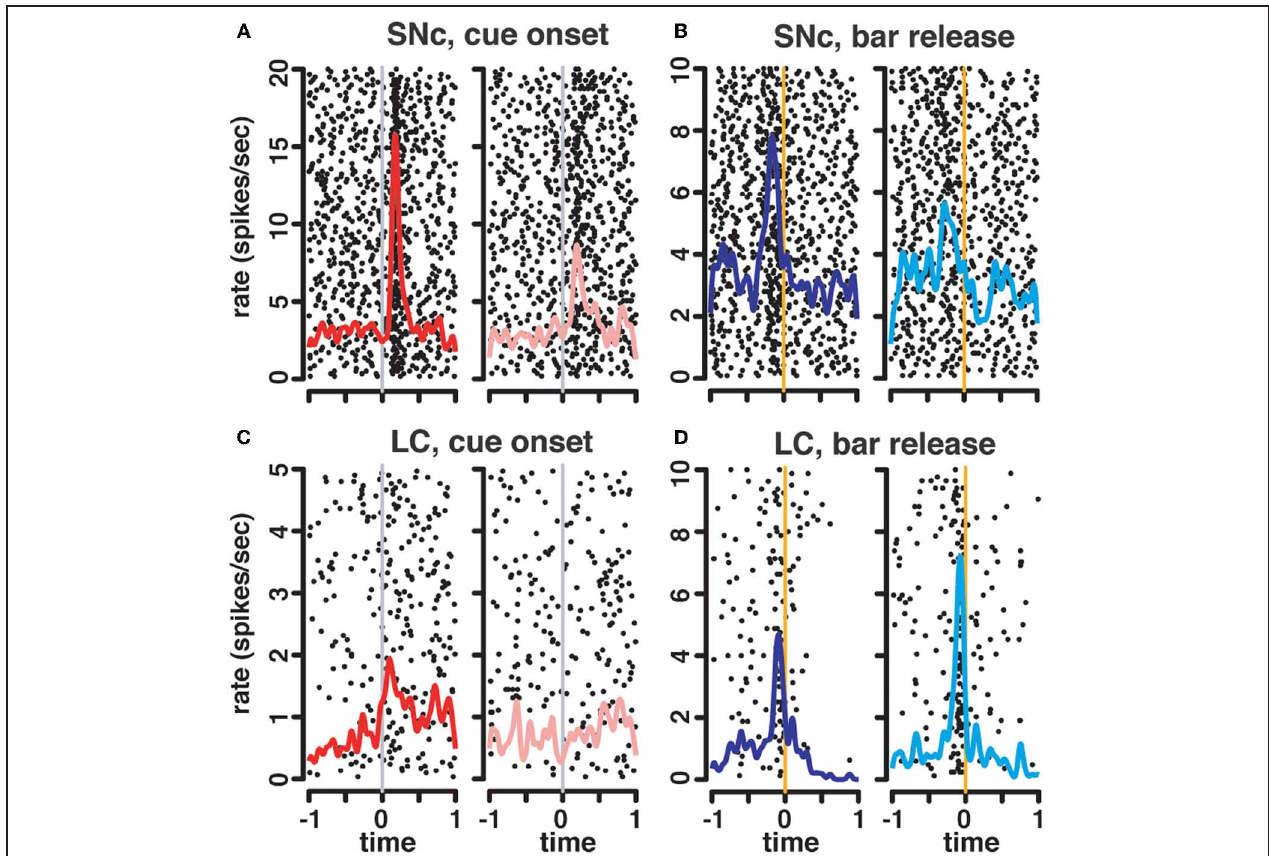
The LC unit (C) only responded to cues signaling the first trial of a schedule, but not subsequent ones. At the bar release, trials were sorted according to whether they were rewarded (dark blue, left), or not (light blue, right). For the SNc unit (B) , there was a greater activation before rewarded bar releases compared to unrewarded ones. On the contrary, in the LC (D) , the activation before the bar release was greater in non-rewarded